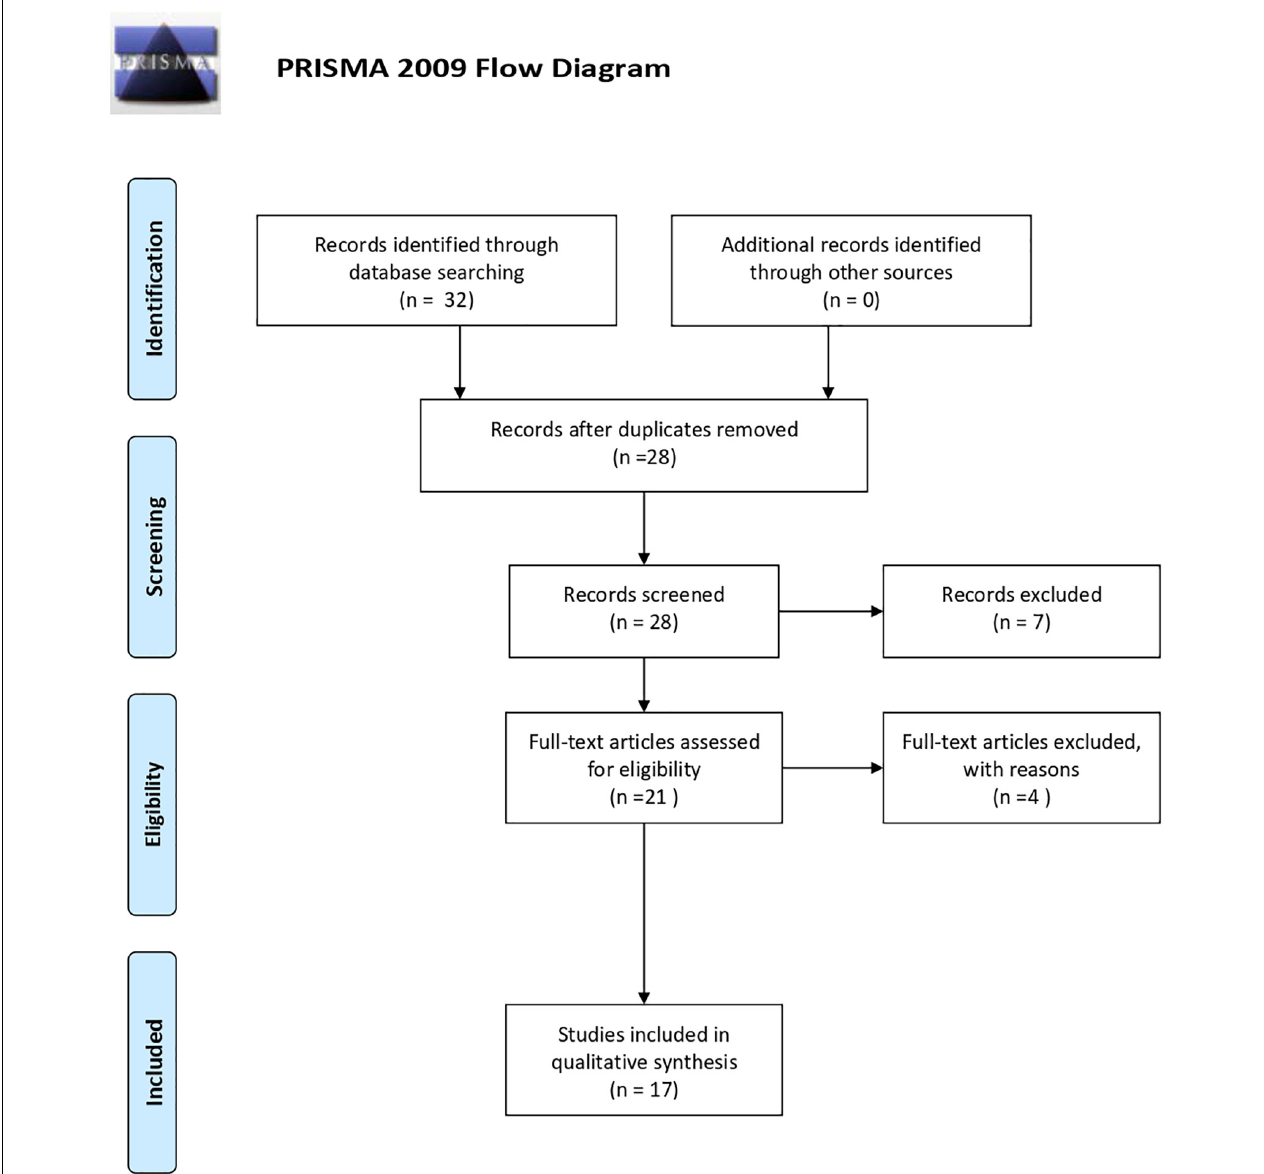
FIGURE 1 | Flow diagram following PRISMA (2009)